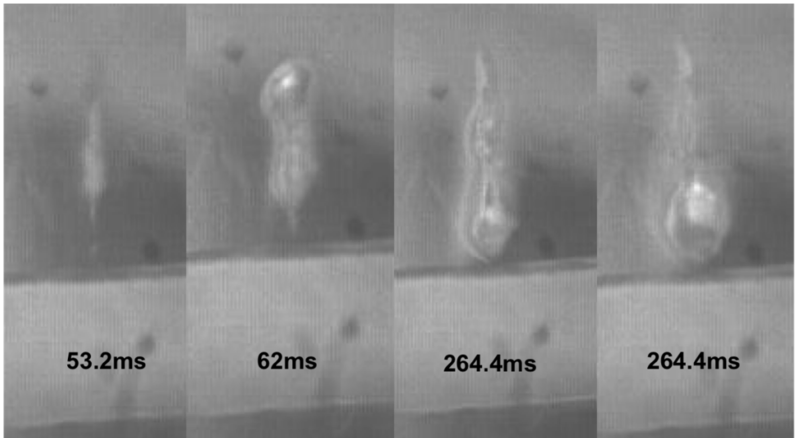
Figure 6. Representative high-speed images of HIFU exposure with its focus aligned to the posterior artery wall.